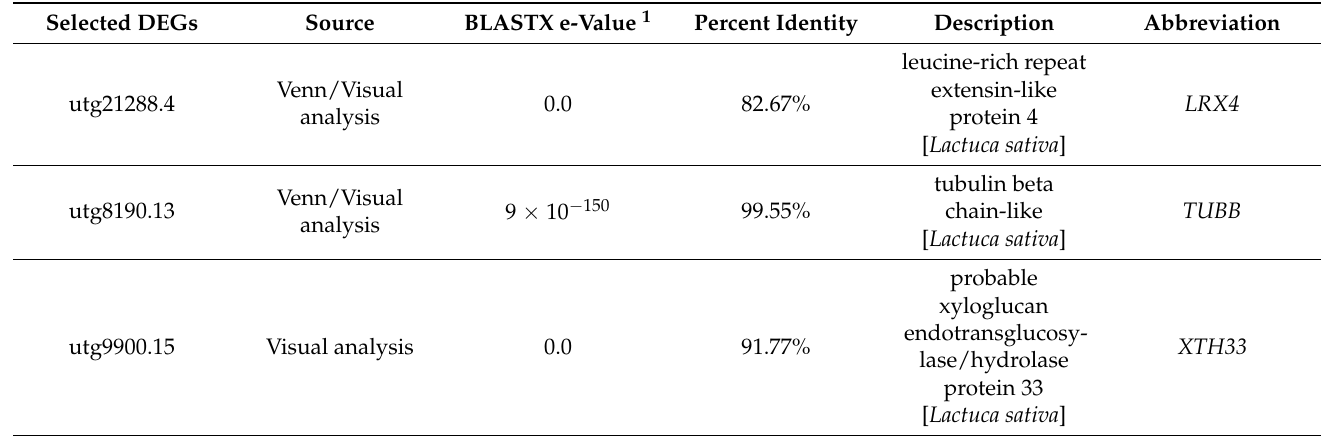
Table 1. Selected DEGs and their BLASTX sequence identity